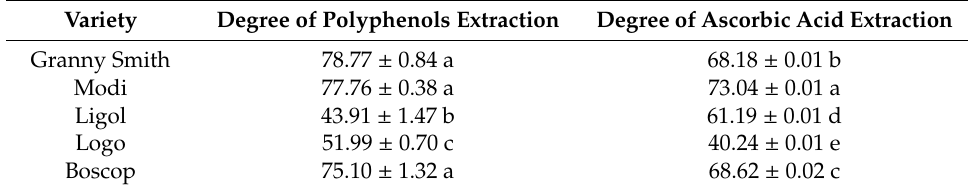
Table 3. Degree of polyphenol and ascorbic acid extraction from whole apples into juice obtained on a twin-screw